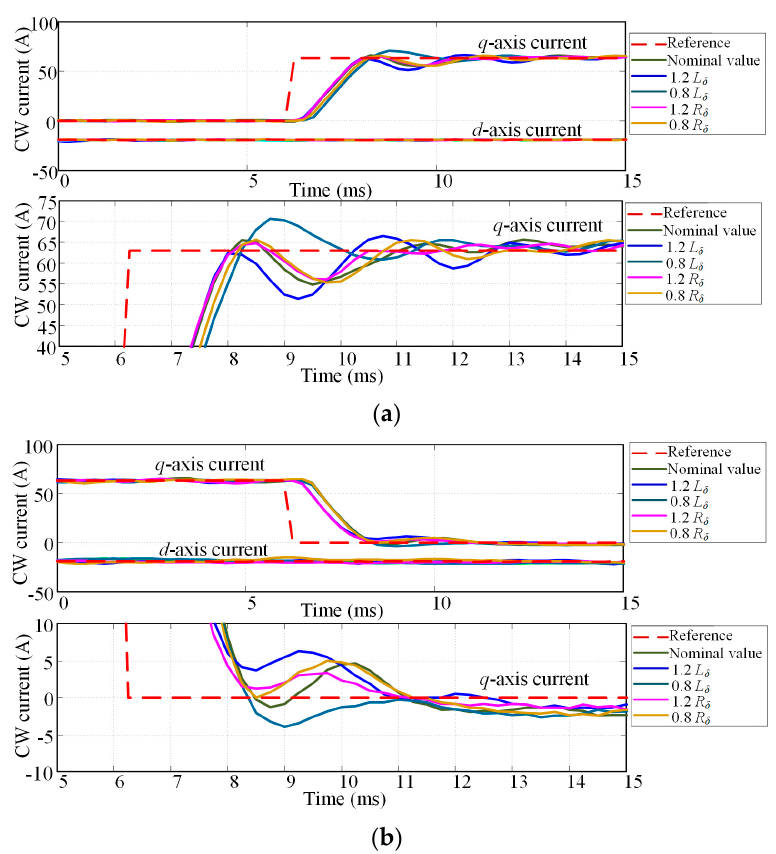
Figure 11. Dynamic responses of the CW current with different estimated parameters at 750 rpm (measure (solid); reference (dashed)). ( a ) i cq changes from 0 A to 63 A; ( b ) i cq decreases from 63 A to 0 A.